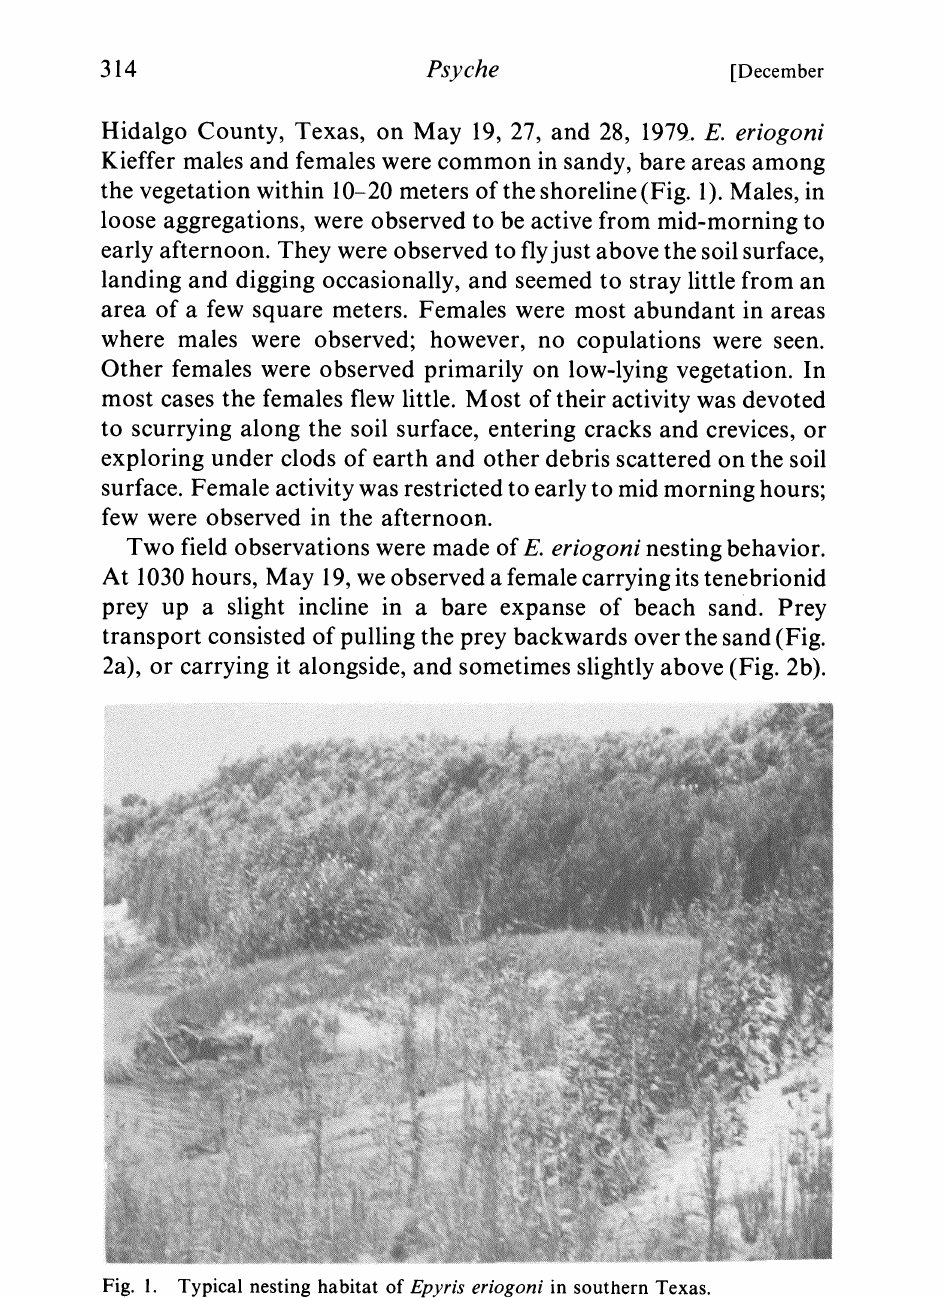
Fig. 1. Typical nesting habitat of Epyris eriogoni in southern